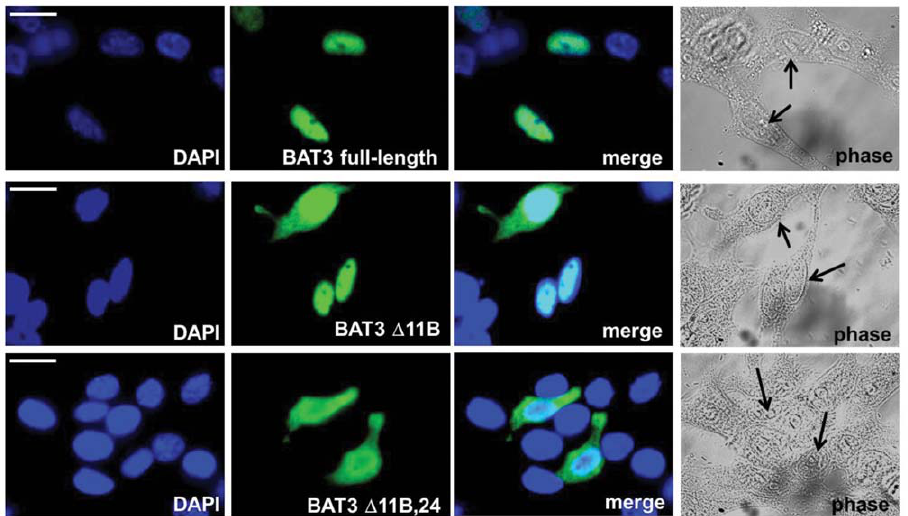
Figure 5. Subcellular localization of BAT3 variants in transfected HeLa cells. Cells were transfected with BAT3 splice variants and stained after 24 hours with a monoclonal V5 antibody for evaluation by immunofluorescence microscopy. Left panel displays DAPI staining, second panel BAT3 staining, third panel merging of images and right panel shows corresponding phase contrast images. The displayed transfected cells show examples for nuclear (BAT3 full-length, upper panel), for nuclear and cytosolic (BAT3 D 11B, middle panel) and for enhanced cytosolic staining (BAT3 D 11B, 24, lower panel). Scale bars=10 m m.